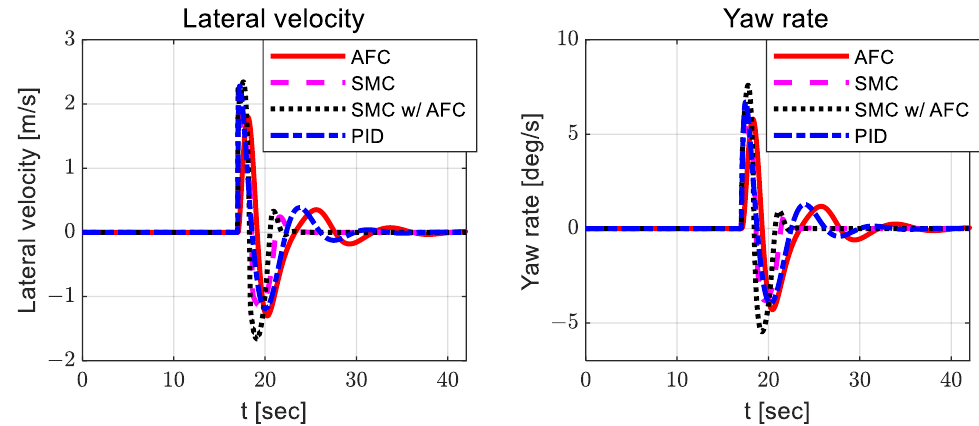
Figure 19. Results: dynamic behaviors (lateral velocity — left ; yaw rate — right ) for the lane change.